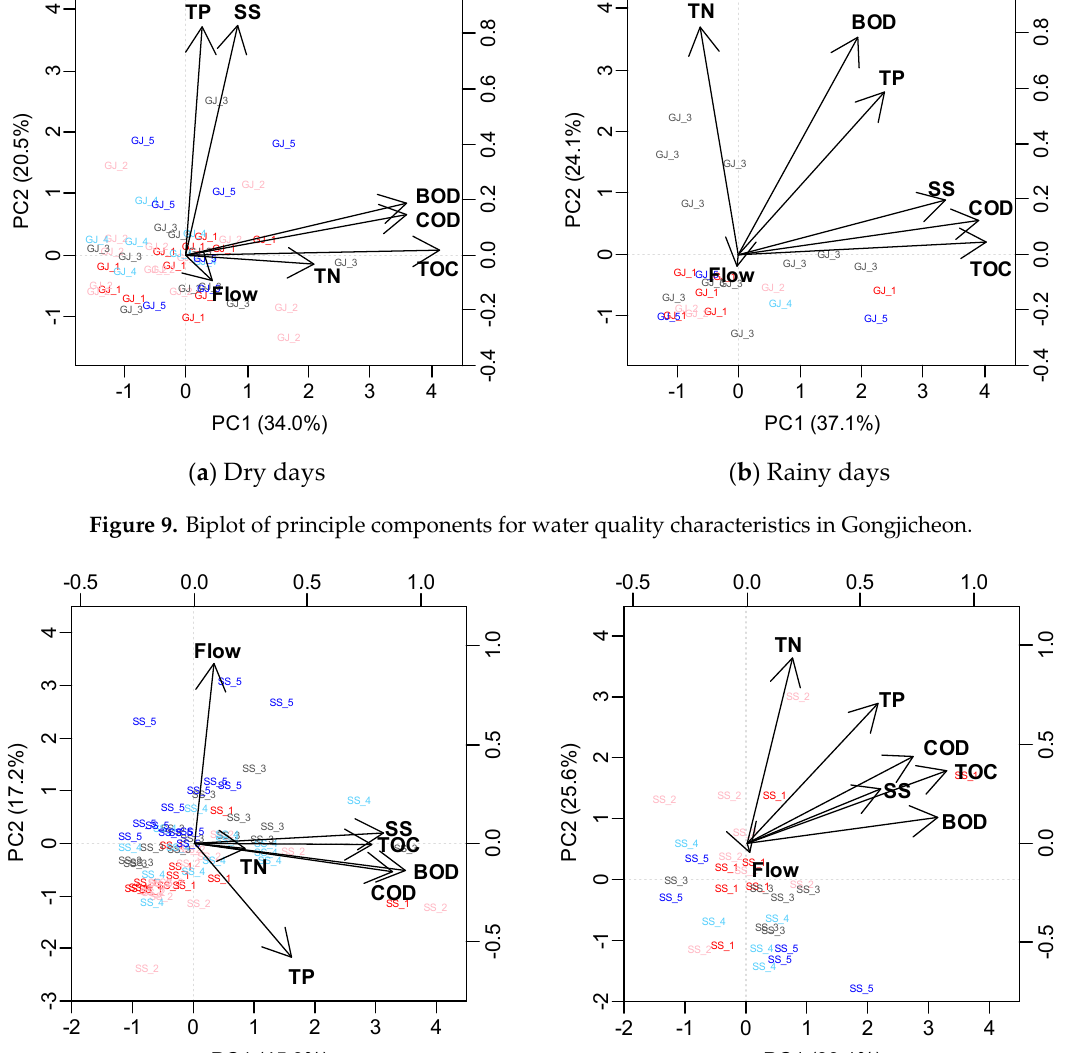
Figure 8. Biplot of principle components for water quality characteristics in Dochoncheon.